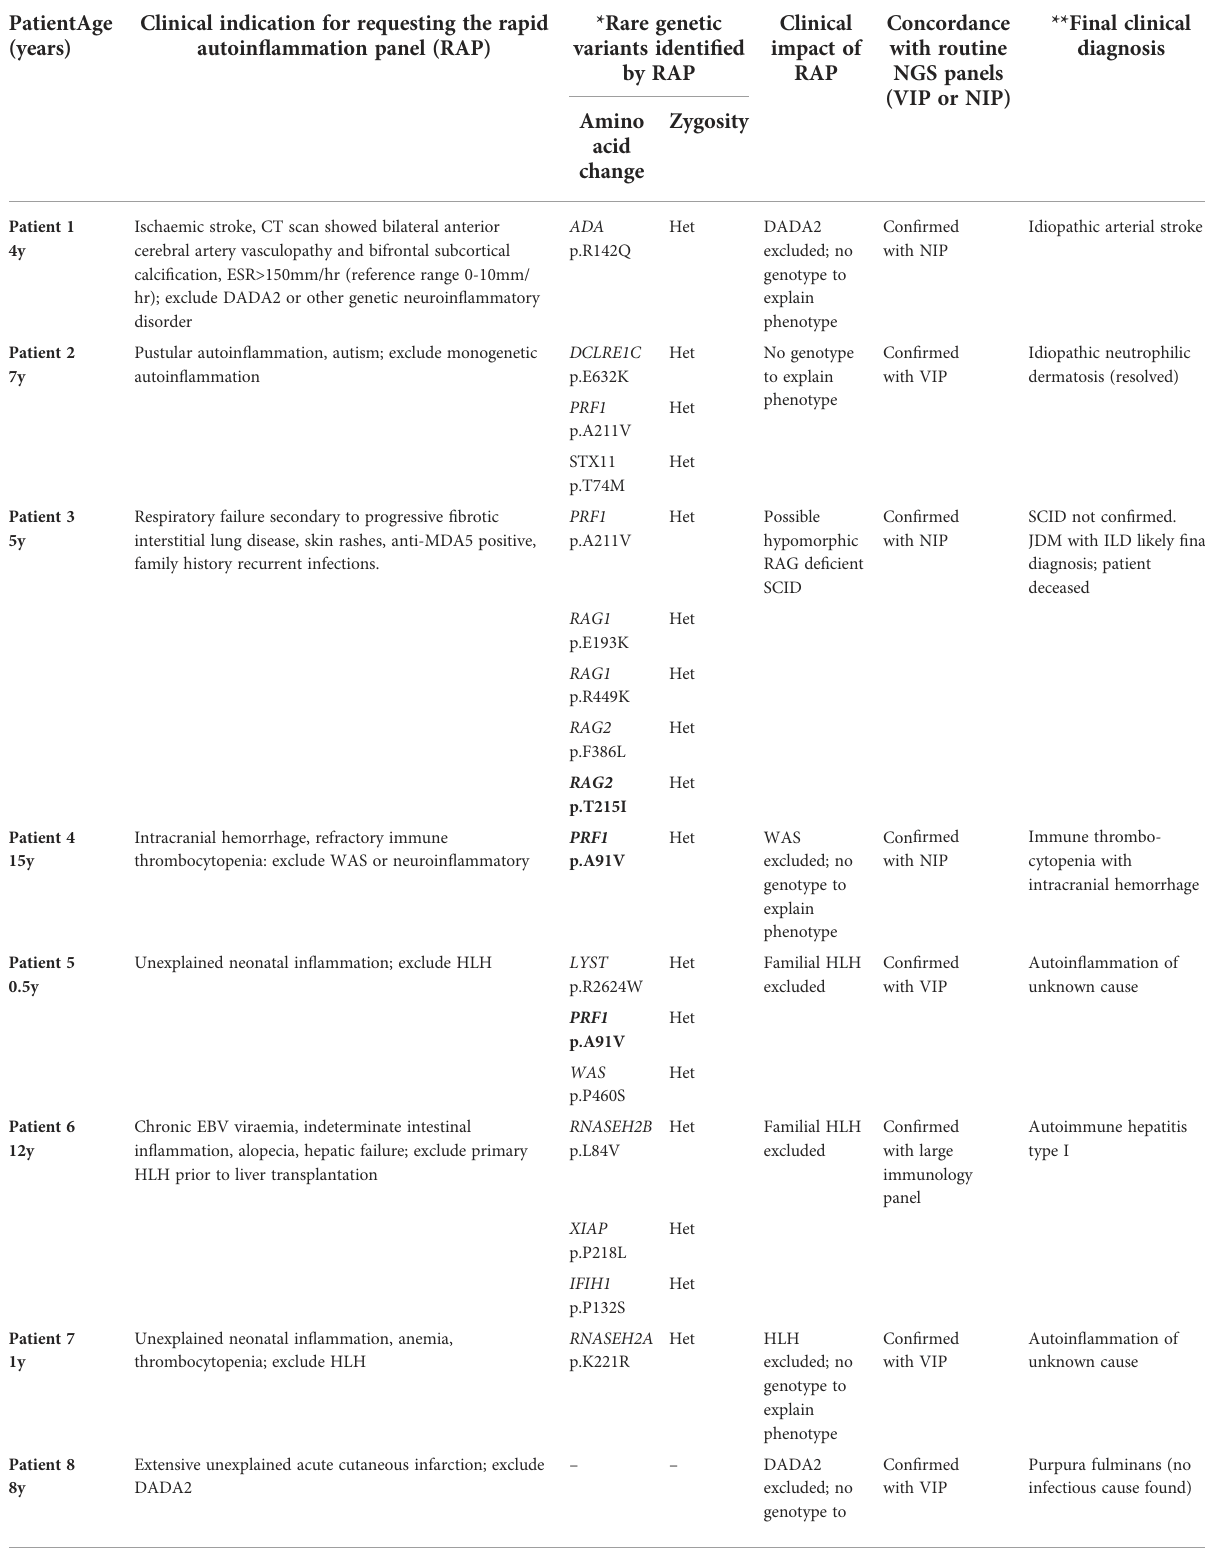
TABLE 2 Prospective patients, clinical indication for requesting the RAP and fi nal